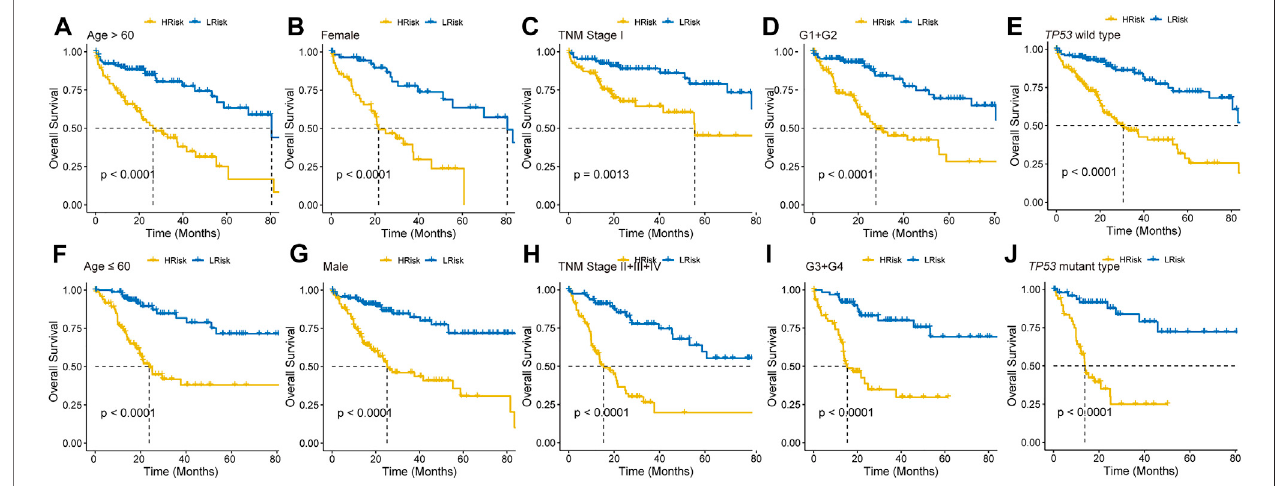
FIGURE 2 | Kaplan – Meier curves analyses of different clinical subgroups in TCGA cohort. Patients were classi fi ed into (A) Age > 60 years, (B) Gender: Female, (C) TNM stage: I, (D) Grade: G1+G2, (E) TP53 wild type, (F) Age ≤ 60 years, (G) Gender: Male, (H) TNM stage: II + III + IV, (I) Grade: G3+G4, and (J) TP53 mutant type.